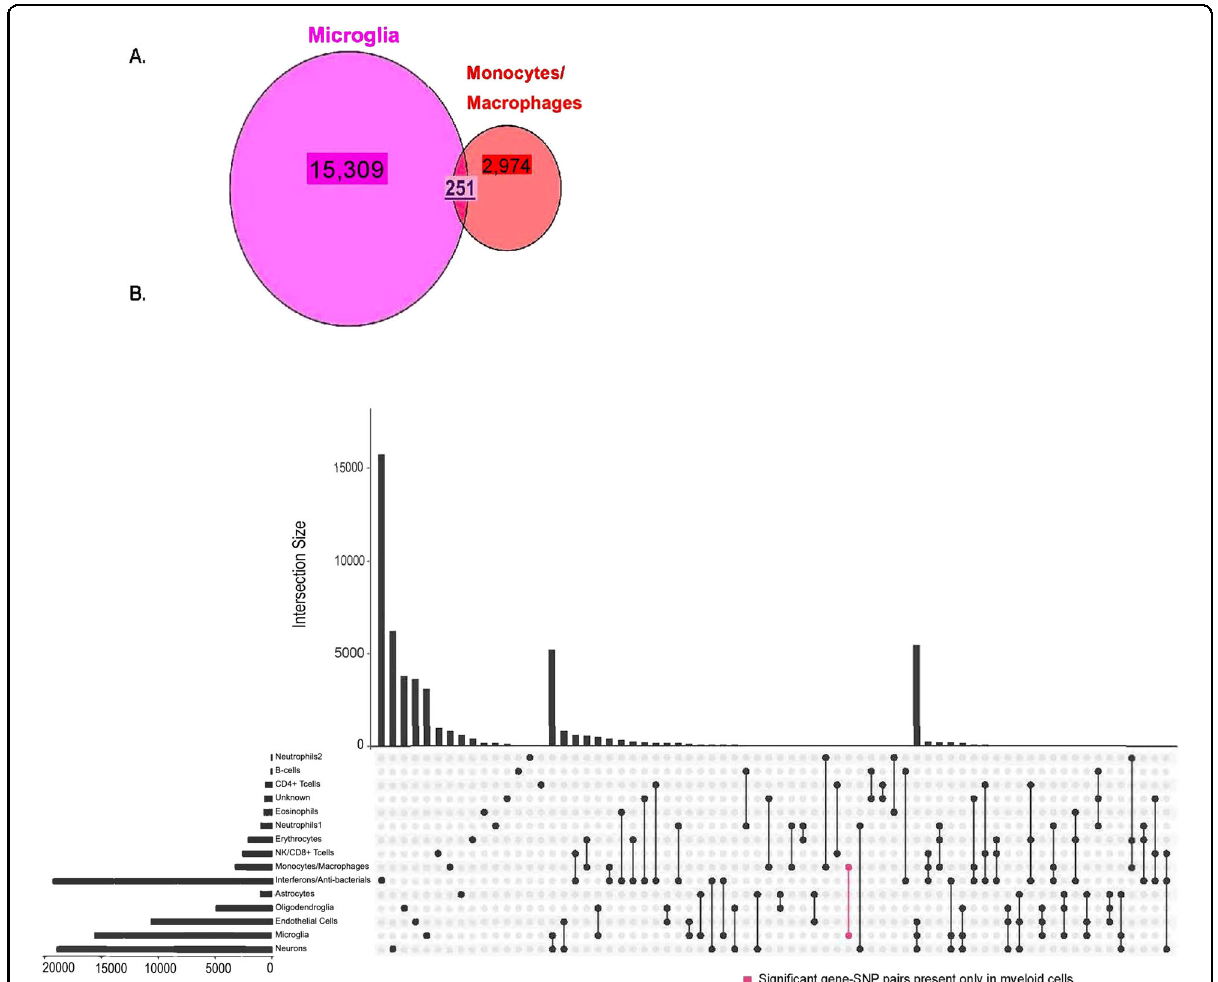
Fig. 2 Intersection of signi fi cant gene-SNP eQTL pairs between cell types in blood and brain tissue. A Venn diagram showing overlap of ct- eQTL pairs in myeloid cell types (microglia and monocytes/macrophages). B Number of signi fi cant eQTLs unique to and that overlap cell types in blood and brain. The bar chart on the left side indicates the number of signi fi cant eQTLs involving each cell type and the bar chart above the matrix indicates the number of signi fi cant eQTLs that are unique to each cell type and set of cell types. Pink colored bar indicates the number of eQTLs pairs that are unique to microglia and